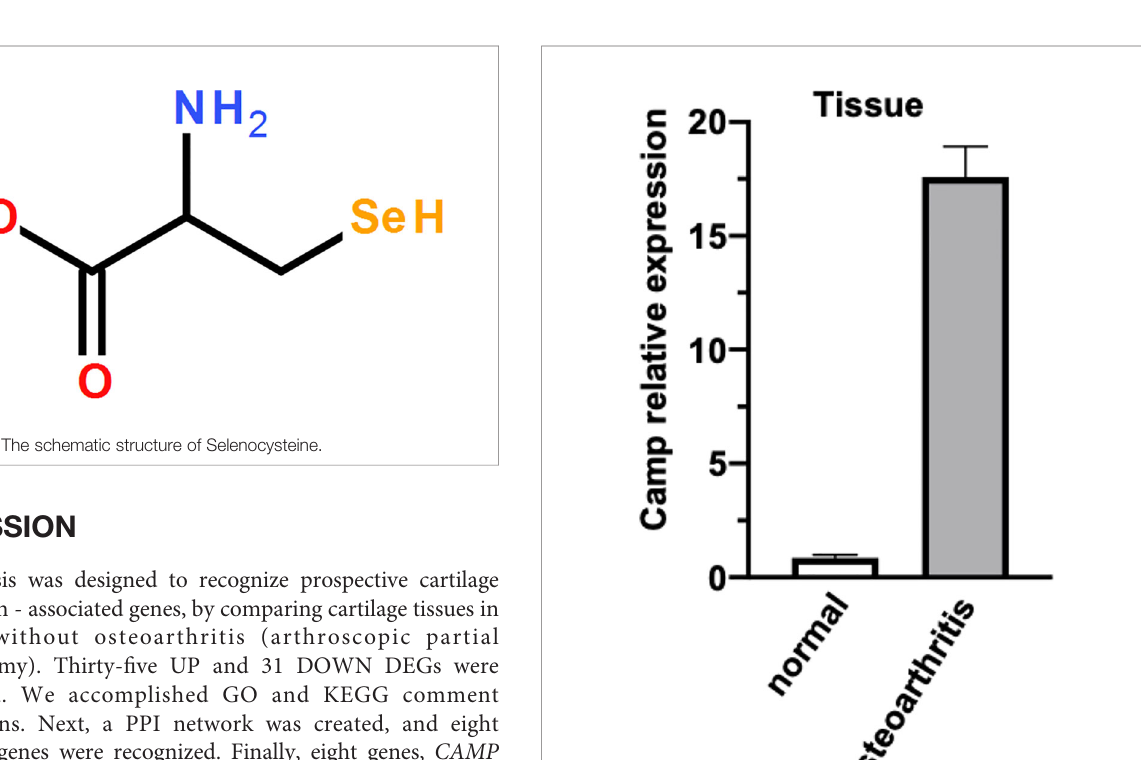
FIGURE 6 | The functional enrichment analysis of eight applicant cartilage regeneration - associated genes (green shows that the gene is enhanced in the related pathway, black shows not on the contrary).